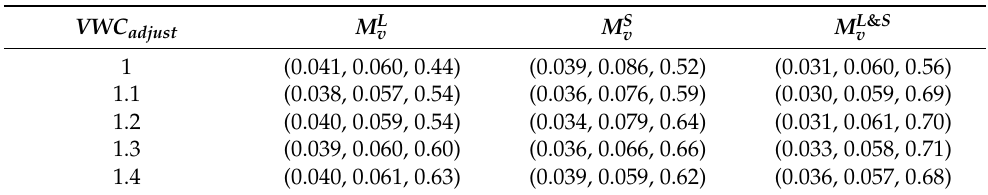
Table 7. Sensitivity test of soil moisture retrieval validation at corn fields for different VWC adjust ;